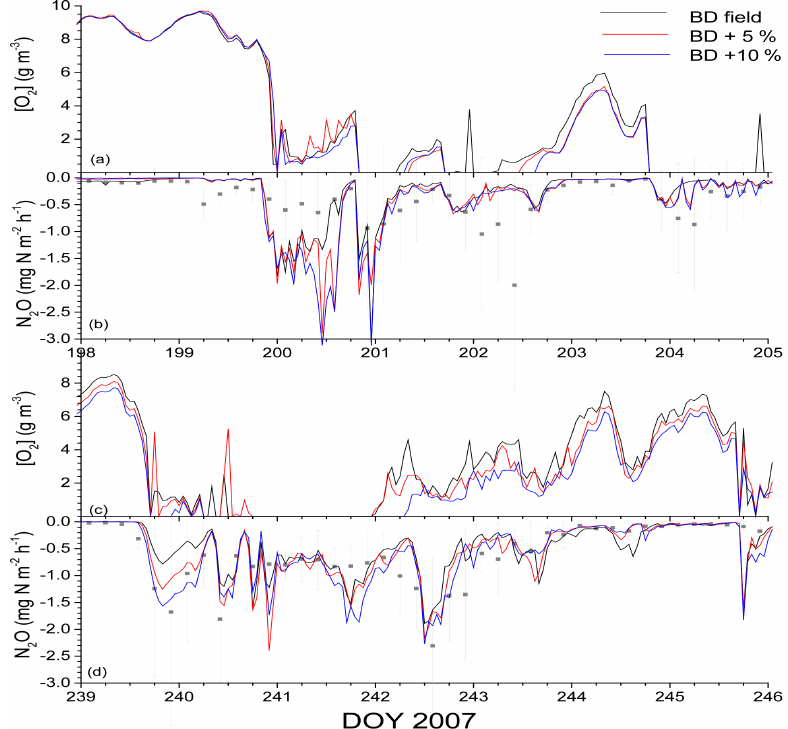
Figure 9. (a, c) Aqueous O 2 concentrations, and (b, d) N 2 O fluxes measured (symbols) and modelled (lines) with bulk density (BD) from field measurements and with BD (0–3cm) raised by 5 or 10% following (a, b) manure application on DOY 194 and (c, d) fertilizer application on DOY 240 in 2007 (see Table 2). For fluxes, positive values represent influxes to the soil, negative values effluxes to the